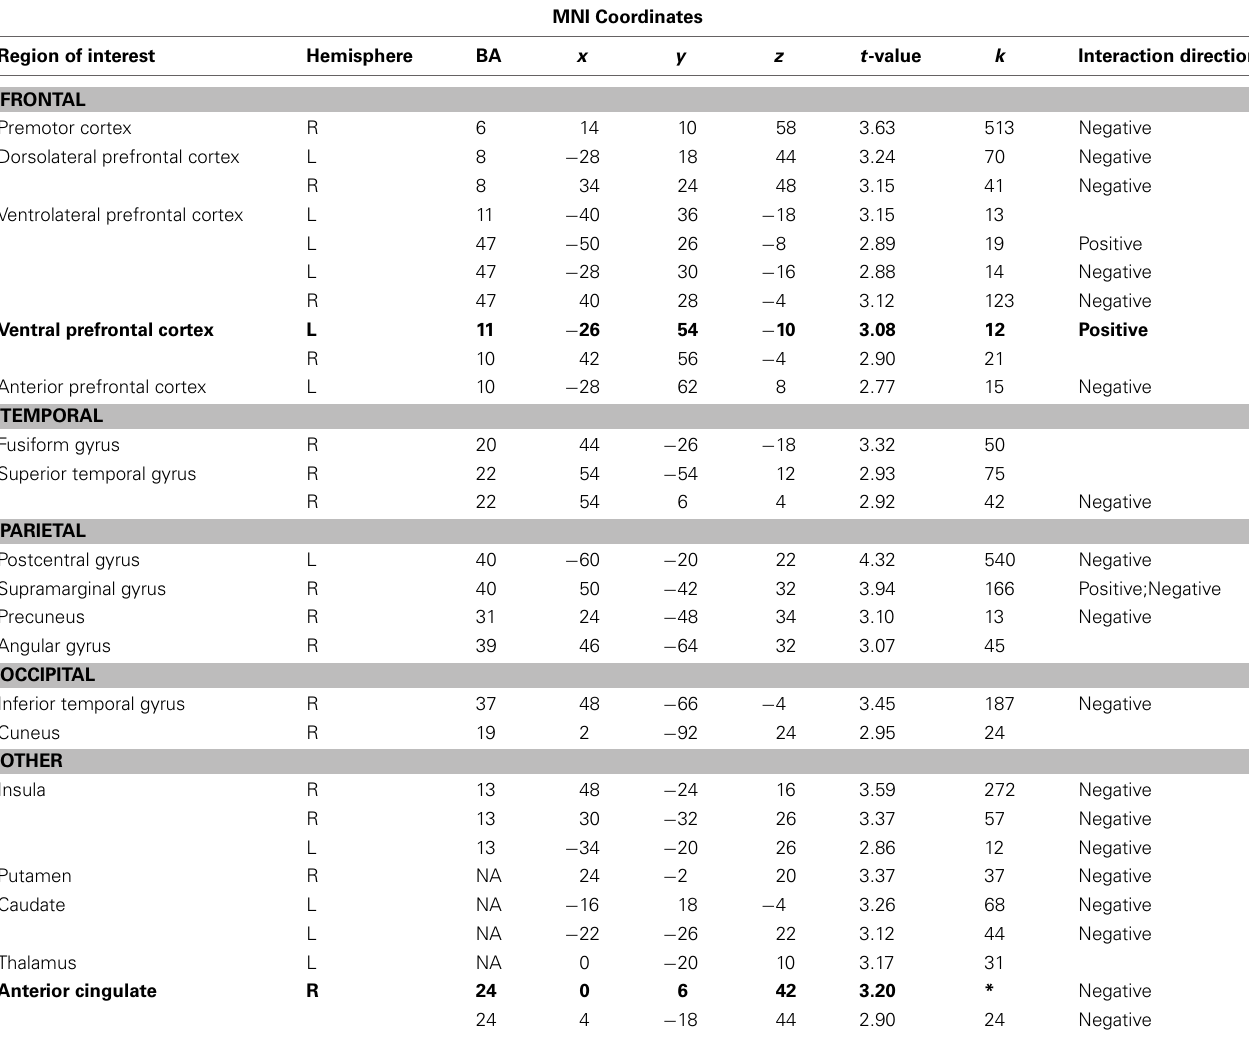
Table 2 | Regions in which the effects of age on the relation between functional and structural connectivity was greater for positive relative to negative event